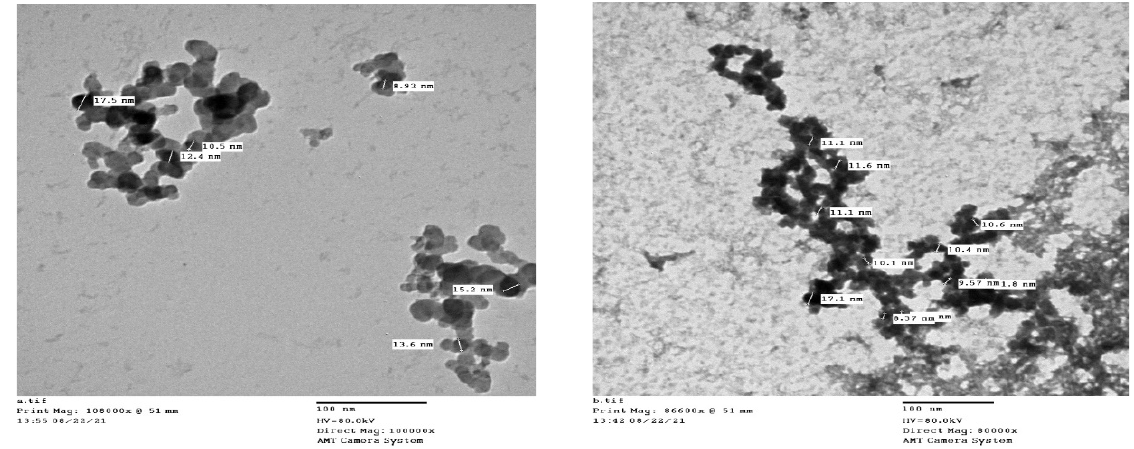
Figure 1. TEM images of Ag-NPs prepared by citrate reduction ( A ) and DRE reduction ( B ).